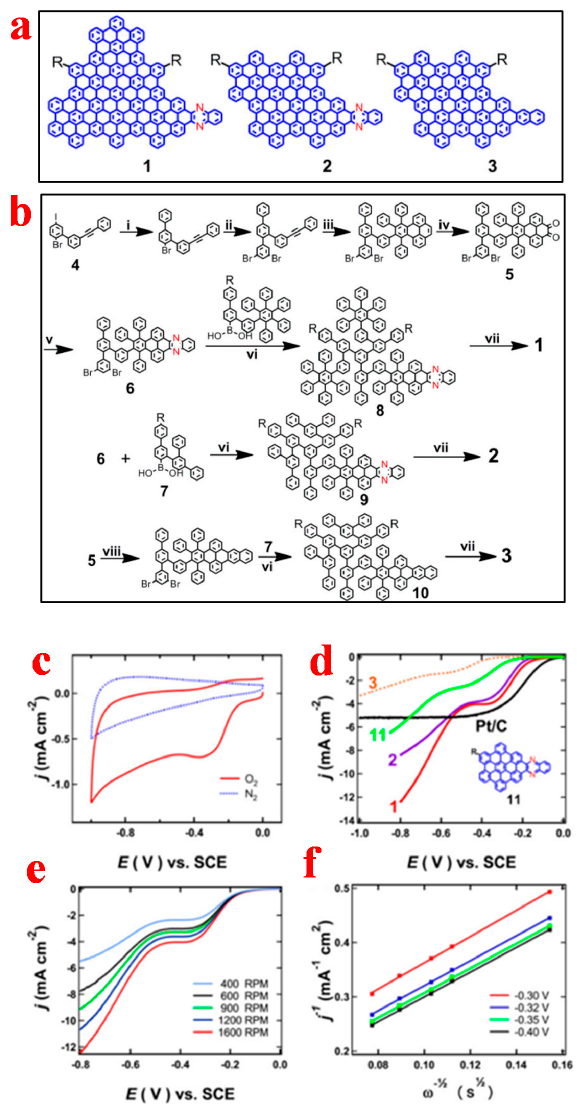
Figure 6. ( a ) Structures and ( b ) synthesis routes of three types of GQDs; ( c ) CV curves of GQD 1 in O 2 ‐ and N 2 ‐ saturated 0.1 M KOH solution at a scan rate of 50 mV ∙ s − 1 ; (vs. saturated calomel electrode (SCE) ) ( d ) LSV curves of these three GQDs and Pt/C in O 2 ‐ saturated 0.1 M KOH solution (1600 rpm); ( e ) LSV curves for GQD 1 with different rotating speeds; ( f ) K ‐ L plots of GQD 1 from LSVs, giving an n of ~3.9. Reprinted with permission from [103]. Copyright 2012, American Chemical Society.